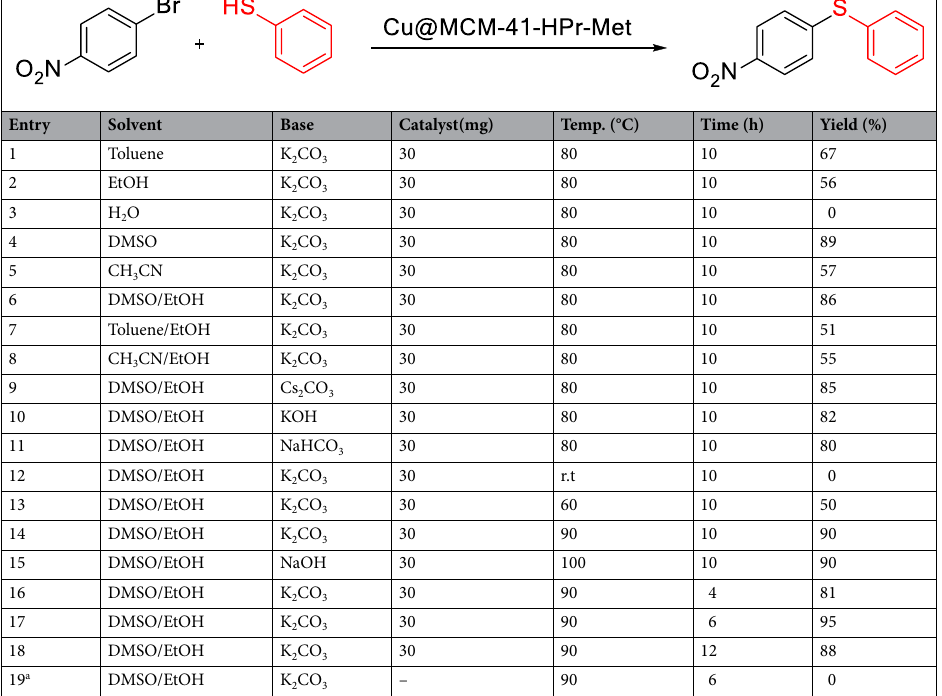
Table 2. Effect of solvents and different bases in C-S bond formation in a reaction between 1-bromo-4- nitrobenzene and thiophenol as a model reaction. a Without catalyst.